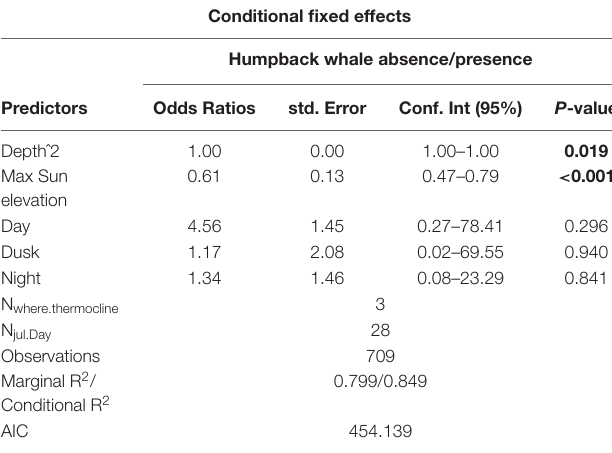
TABLE 2 | Model output for humpback